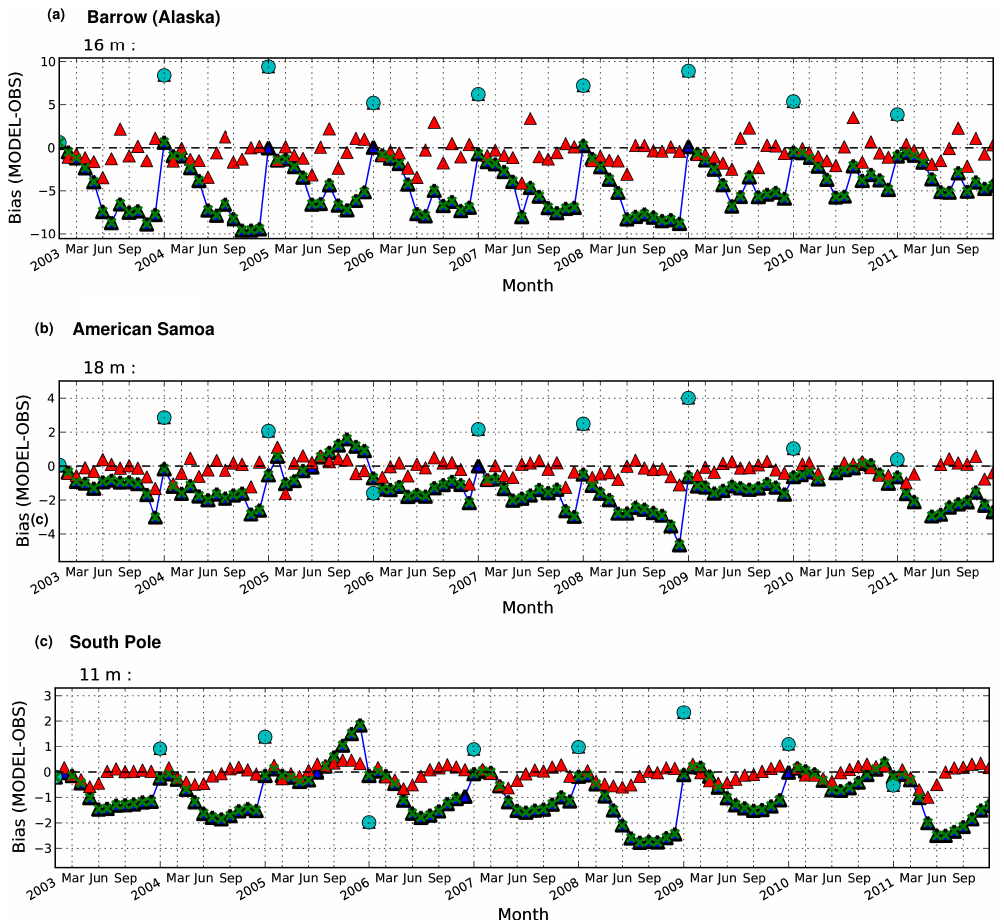
Figure 4. Monthly bias (hindcast – observation) of CO 2 dry molar fraction [ppm] at NOAA/ESRL continuous surface sites sampling back- ground air (green triangles) and differential monthly biases (i.e. difference of monthly bias with respect to previous month) as red triangles from 2003 to 2011. The blue dots highlight the adjustment in CO 2 at the beginning of each year when the model is re-initialized with a simulation from optimized fluxes which has a bias close to zero (see text for